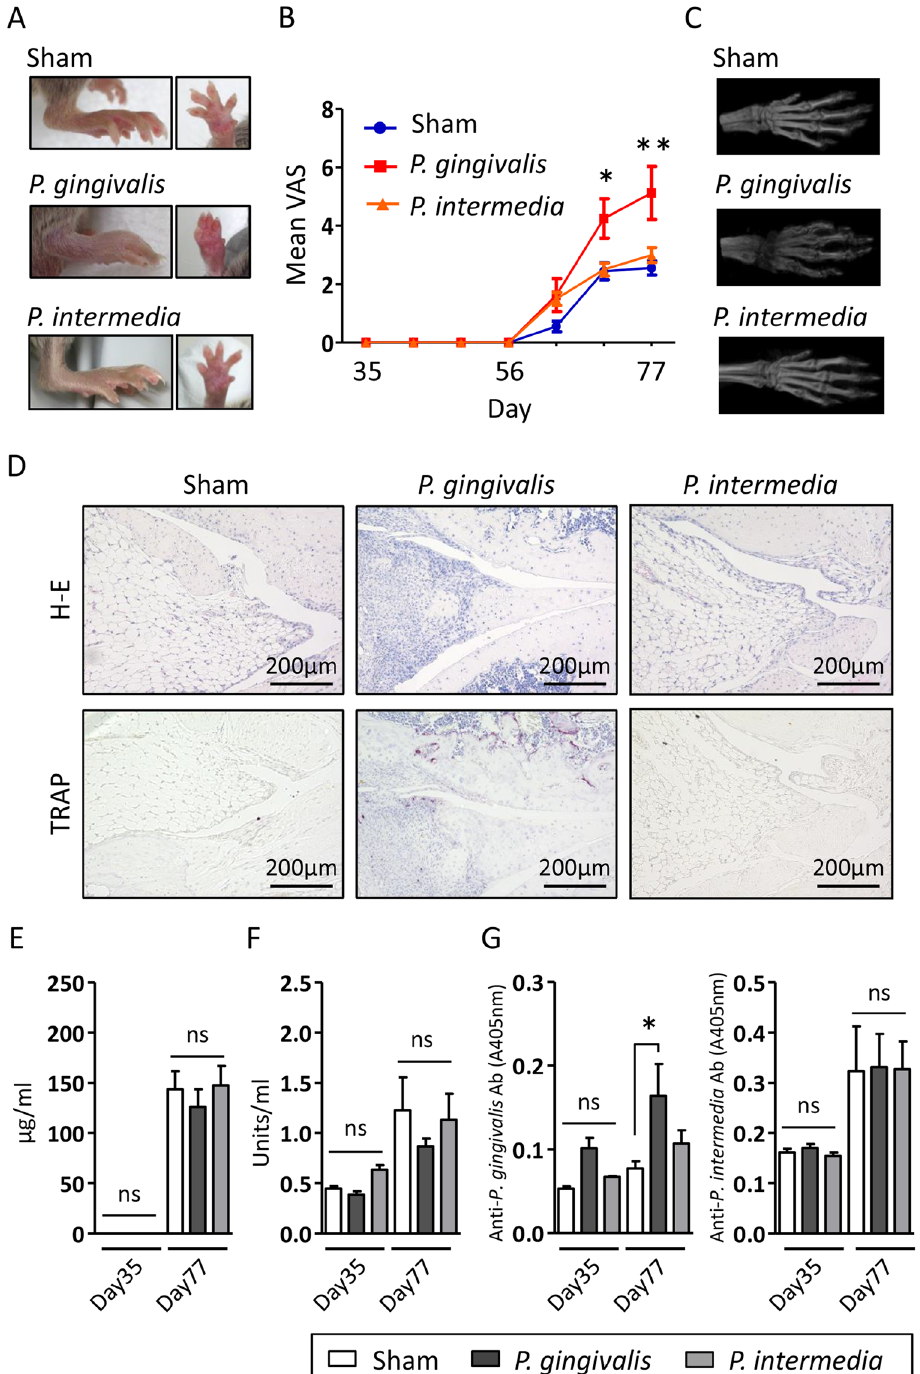
Figure 1. Effect of P. gingivalis administration on clinical features and serum levels of antibodies in a CIA model. ( A ) Representative image of the hind paw of sham-, P. gingivalis -, and P. intermedia -administered mice following CII immunisation. ( B ) Visual assessment score (VAS) of sham-, P. gingivalis -, and P. intermedia - administered mice. ( C ) Micro-computed tomographic appearance of the paws of sham-, P. gingivalis -, and P. intermedia -administered mice. ( D ) Histological analysis of the knee joints of sham-, P. gingivalis -, and P. intermedia -administered mice. Sections were stained with haematoxylin and eosin, and tartrate-resistant acid phosphatase in combination with haematoxylin. Serum levels of anti-CII antibodies ( E ), anti-cyclic citrullinated protein (CCP) antibodies ( F ), and IgG antibodies against P. gingivalis W83 and P. intermedia ATCC 25611 ( G ) were compared between sham-, P. gingivalis -, and P. intermedia -administered mice. Sera were obtained immediately before immunisation (day 35) and after induction of CIA (day 77). Data represent the mean ± standard error of the mean (SEM) (N = 6 for ( A , B , E , F and G ). * p < 0.05, ** p < 0.01, One-way ANOVA with Bonferroni corrections for multiple